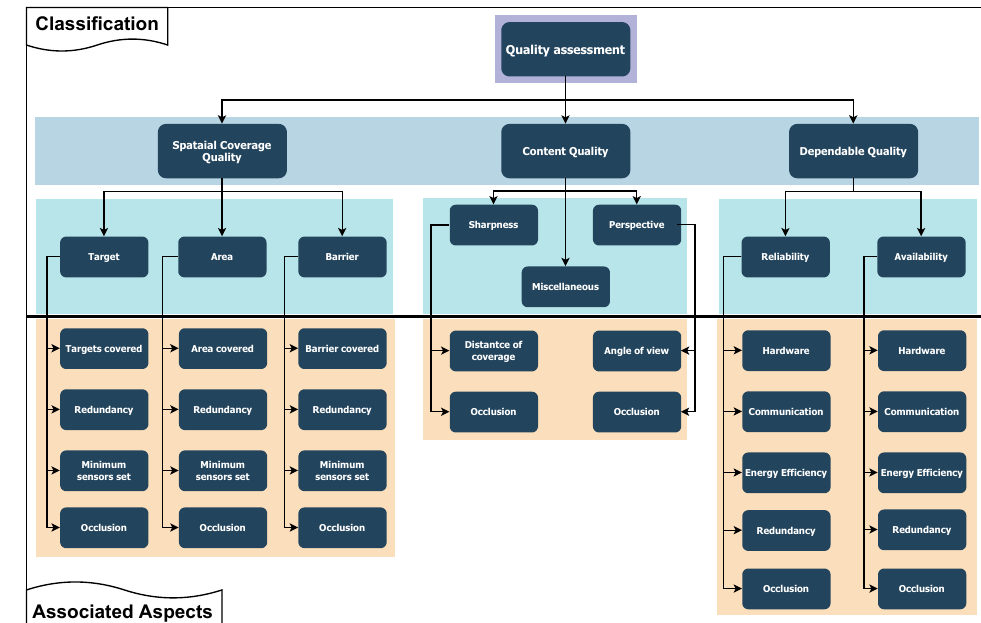
Figure 1. Proposed classification and commonly associated coverage